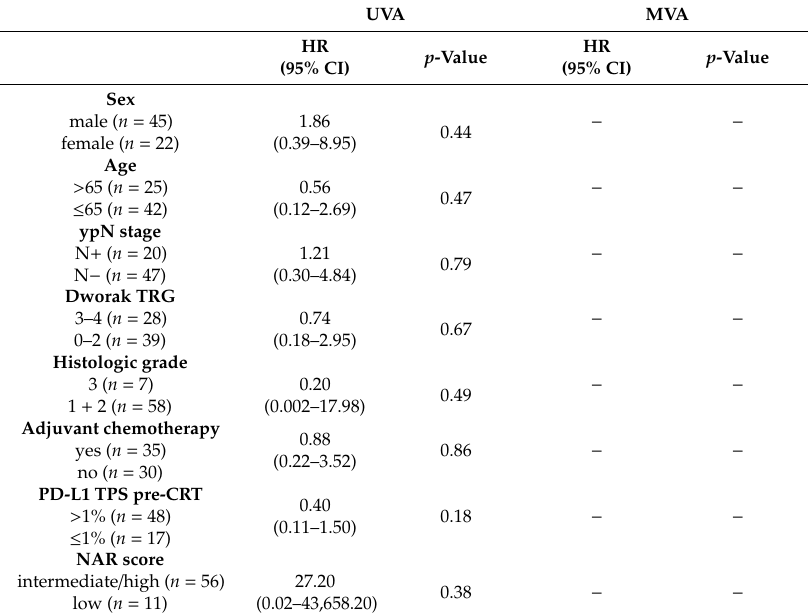
Table 2. Univariate and multivariate analysis for disease-free survival.